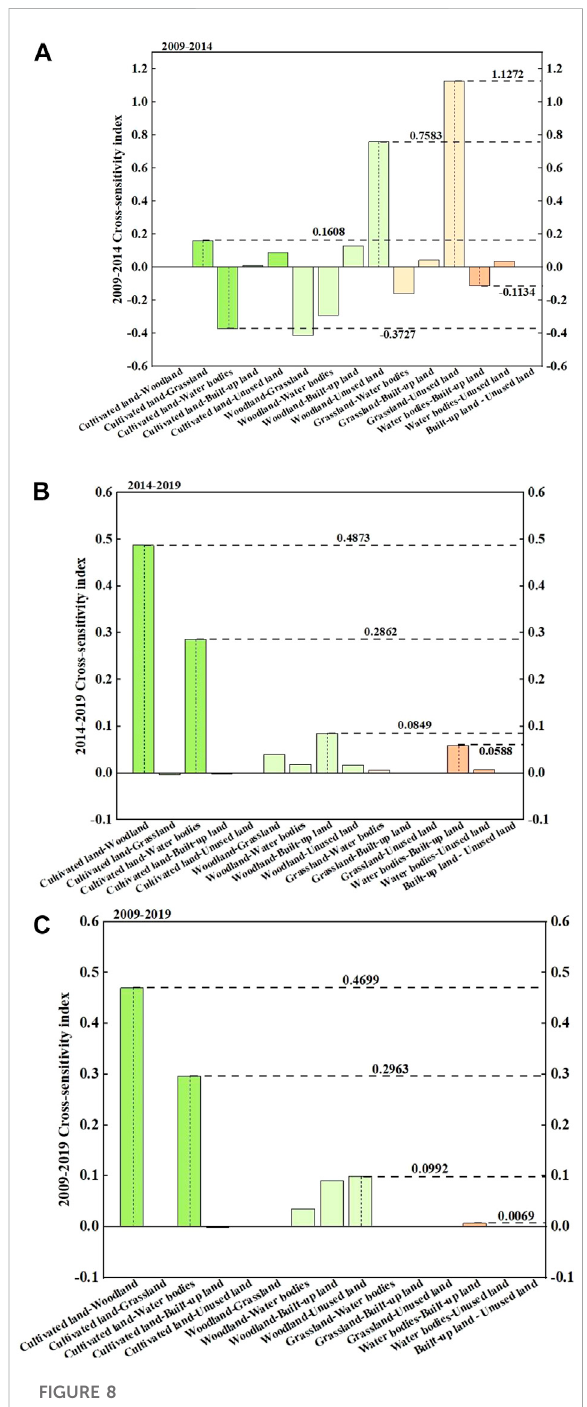
FIGURE 8 Cross-sensitivity index of ecosystem service value in Jiangjin during 2009 – 2019. (A) : cross-sensitivity of ecosystem service value from 2009 to 2014; (B) : cross-sensitivity of ecosystem service value from 2014 to 2019; (C) : cross-sensitivity of ecosystem service value from 2009 to